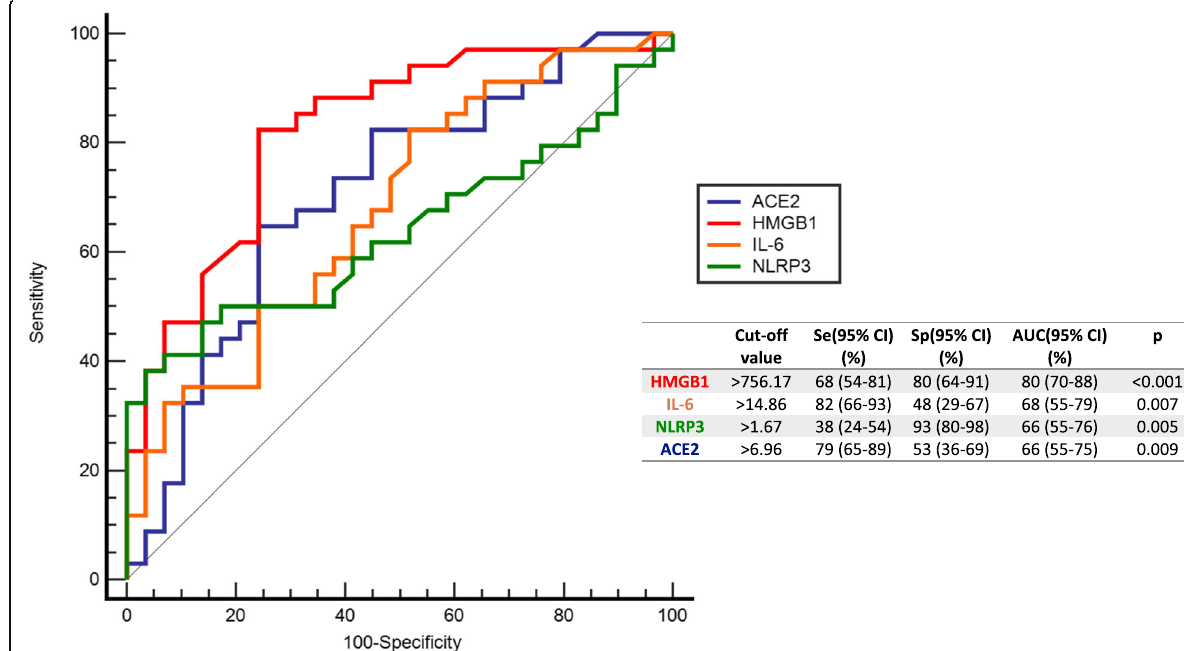
Fig. 2 Independent ROC curves illustrated the differentiating abilities of HMGB1, IL-6, NLRP3 and ACE2 ( n = 88). Both sensitivity (Se) and specificity (Sp) values showed that classification performance of HMGB1 was better than the others. On the other hand, IL-6 and ACE2 were found to be successful in classifying COVID-19 patients with headache, while NLRP3 were found to be more successful in classifying COVID-19 patients without headache. Combined performance of these inflammatory molecules was found to be highly successful (Area under curve AUC = 0.92, Se = 0.83, Sp = 0.88)